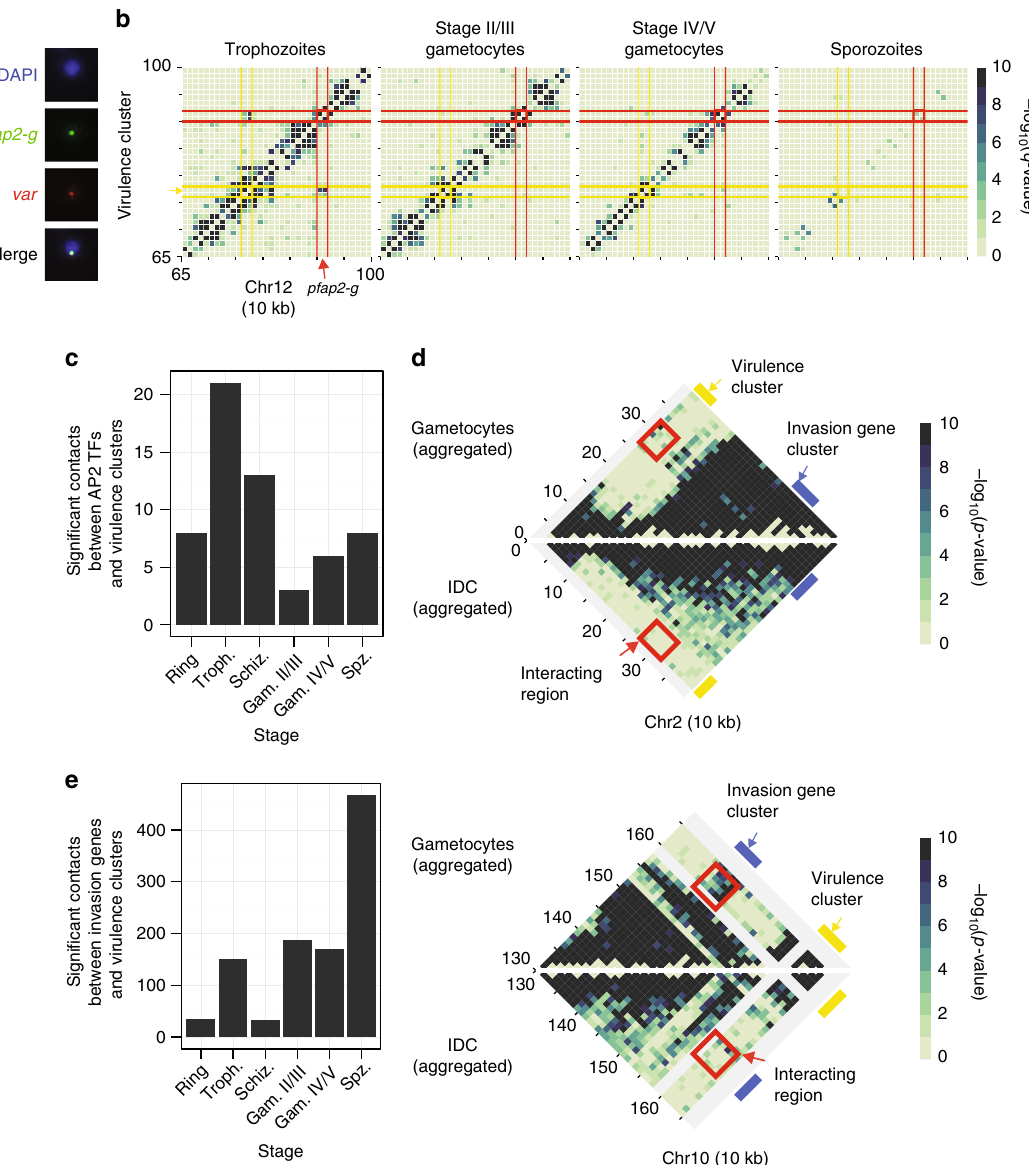
Fig. 2 Changes in interaction of pfap2 genes and invasion genes with the repressive center. a Colocalization of pfap2-g and var gene PF3D7_0800300 by DNA-FISH. Additional images are presented in Supplementary Fig. 8. b Dissociation of the gametocyte-speci fi c transcription factor locus pfap2-g (red) from the nearby internal virulence gene cluster (yellow) in stage II/III gametocytes. c Overall reduced number of intrachromosomal and interchromosomal interactions between pfap2 TF genes and virulence genes in gametocytes and sporozoites as compared to the IDC stages. d Invasion gene clusters (blue bar) on chromosomes 2 (top) and 10 (bottom) interact with subtelomeric virulence genes (yellow bar) in gametocytes, but not during the IDC. In each plot, the top triangle shows the aggregated data of both gametocyte stages, while the bottom triangle shows the aggregated data from the three IDC stages. Bins that depict interactions between virulence genes and invasion genes are highlighted by a red box. e Increased number of intrachromosomal and interchromosomal interactions between invasion genes and virulence genes in gametocytes and sporozoites as compared to the IDC